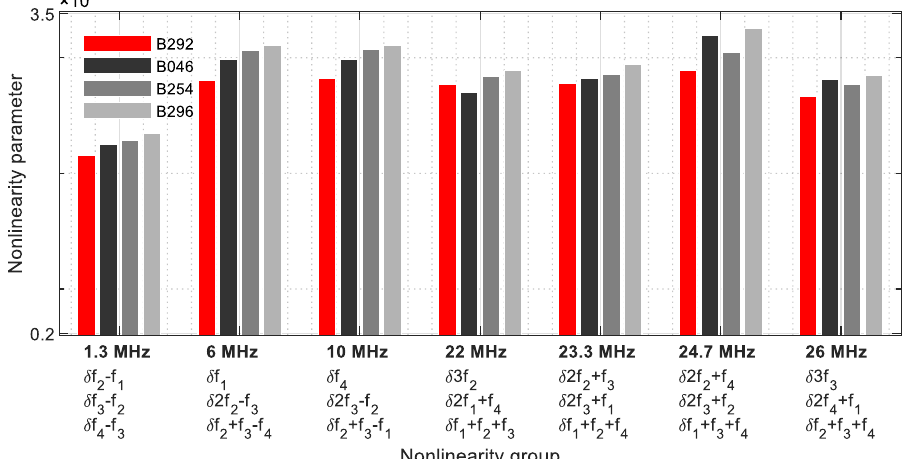
Figure 33. Nonlinearity parameter — δ G2 .